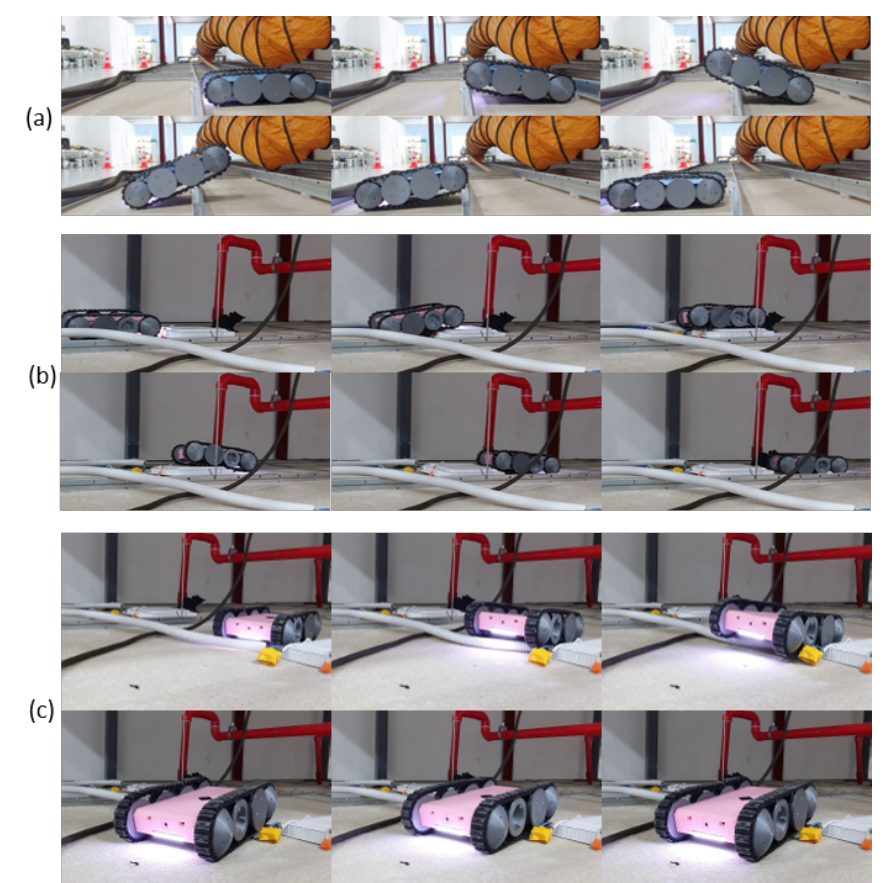
Figure 8. Sequence of snapshots taken when the robot traverses different components of a false